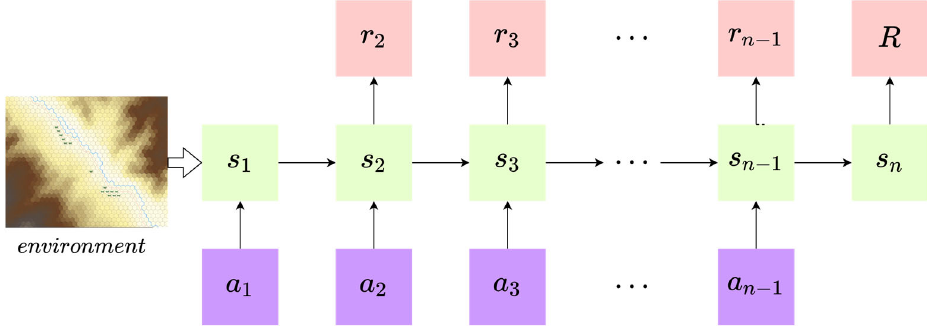
Figure 8. The reward structure of a wargame with an additional reward function.